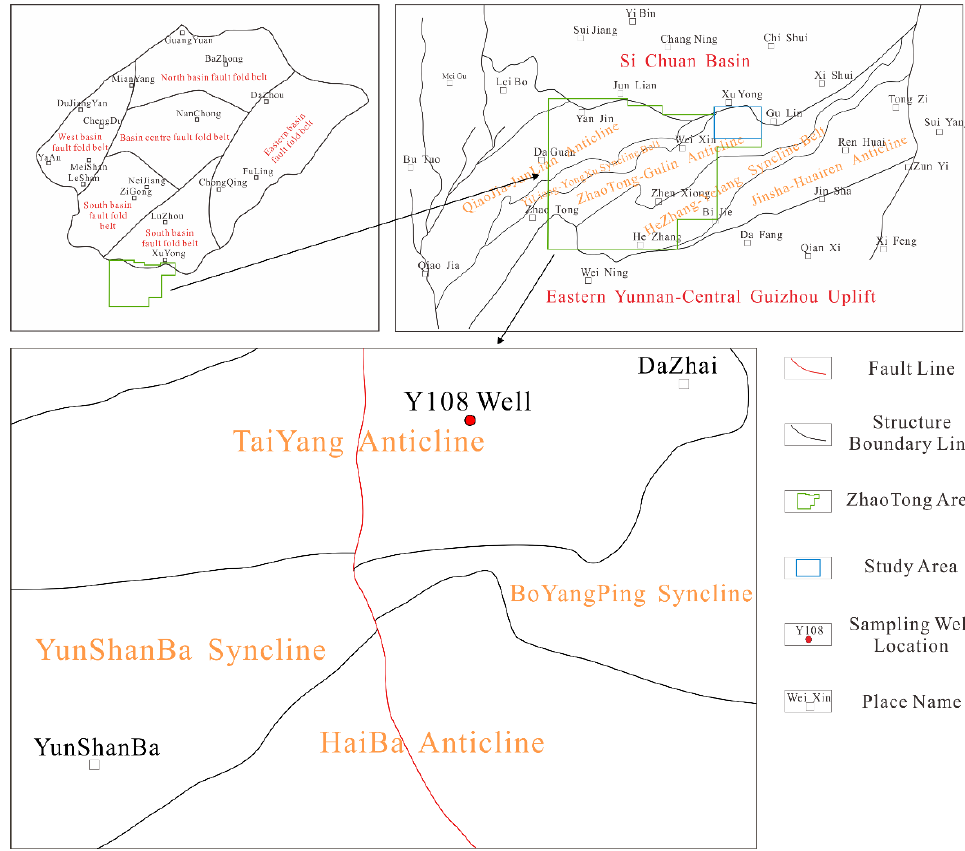
Figure 1. Structural map and sampling well location of Wufeng–Longmaxi Fm in Zhaotong area.